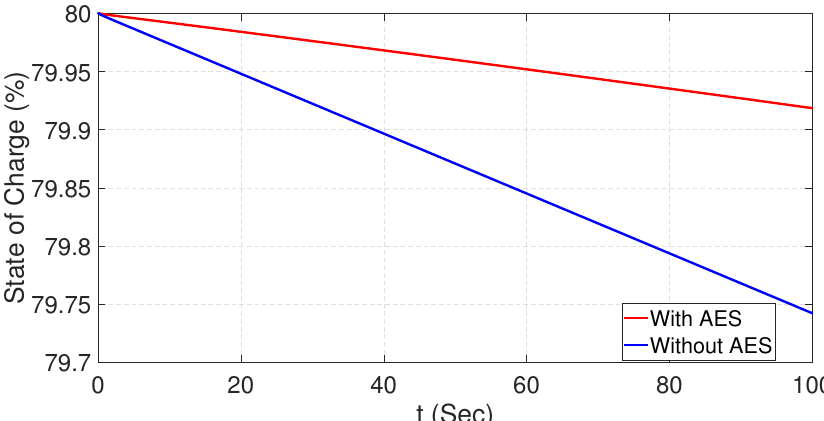
Figure 9. AES supercapacitor SOC. ( a ) Illustrate the obtained current during the vehicle operation, ( b ) the obtained voltage during the vehicle operation and ( c ) the state of charge of the supercapacitor during the operation.